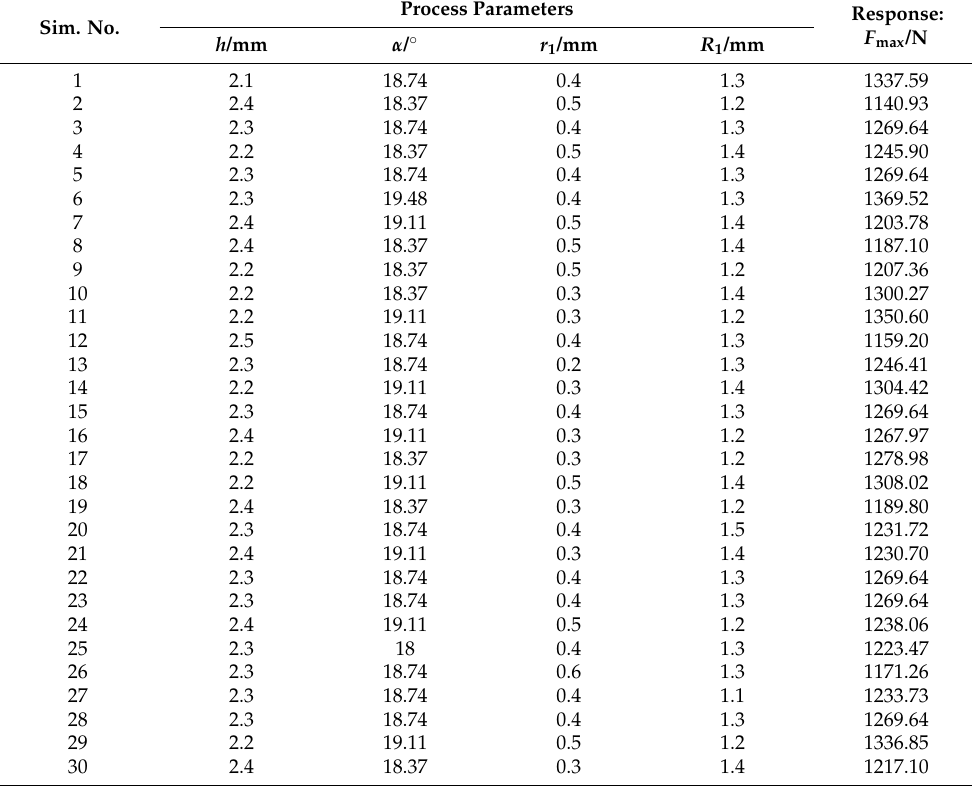
Table 2. Input process parameters and their corresponding response for different simulated runs. Process Sim. No.